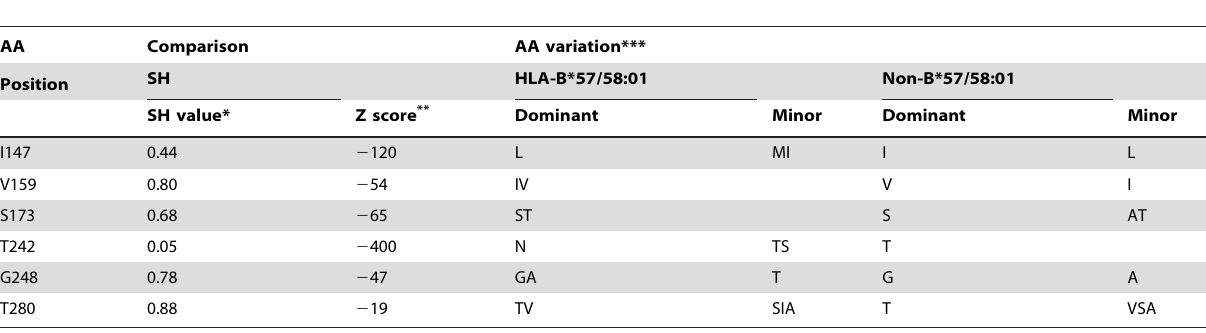
Table 2. Amino acid variation in Gag p17 and p24 specific for HLA-B*57/58:01.